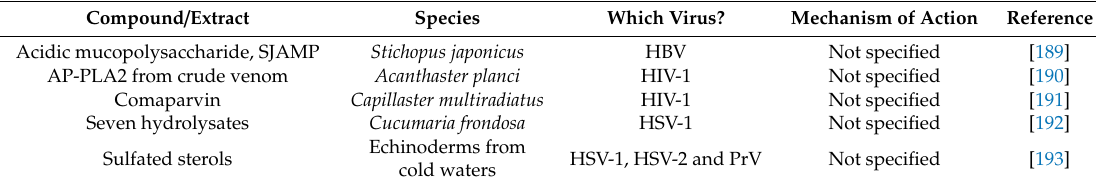
Table 10. The table report antiviral compounds / extracts from echinoderms. HBV, Hepatitis B virus; HIV-1, Human immunodeficiency virus type 1; HSV-1, Herpes simplex virus 1; HSV-2, Herpes simplex virus 2, PrV, Pseudorabies virus; PLA2, phospholipase A2.